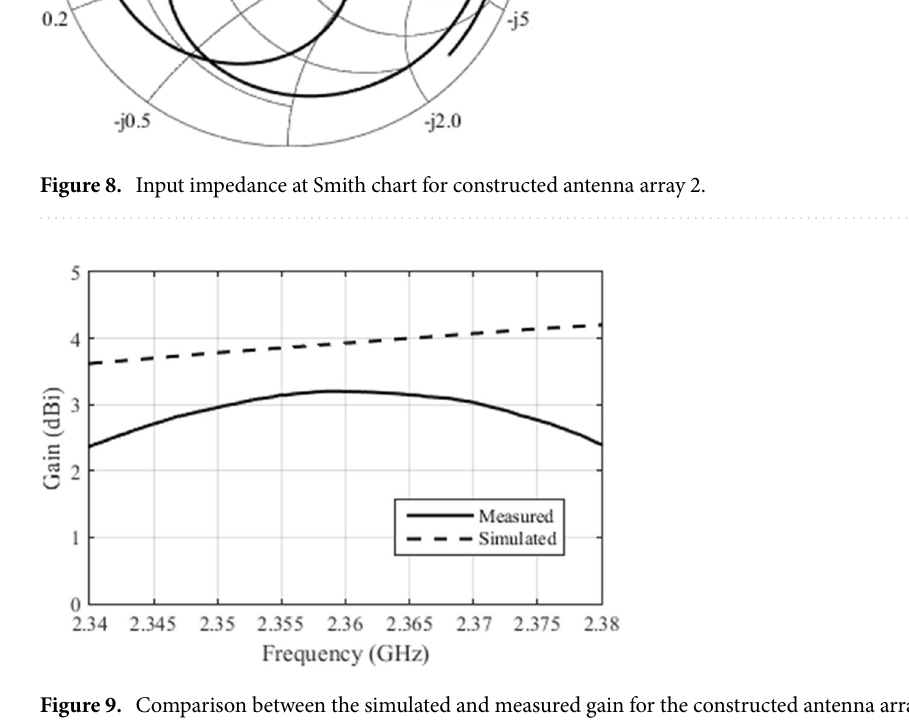
Figure 9. Comparison between the simulated and measured gain for the constructed antenna array